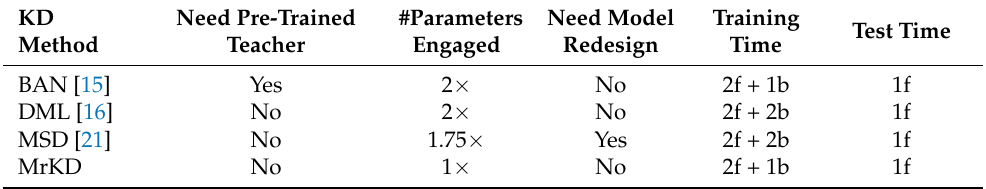
Table 1. Summary of different Knowledge Distillation (KD) methods in implementation and compu- tation complexity. Note that we adopt ’f’ and ’b’ as units to indicate the forward propagation and backward propagation time of the student network. The results are shown with only one teacher (Born Again Network—BAN and Memory-replay Knowledge Distillation—MrKD), peer (Deep Mutual Learning—DML), or branch